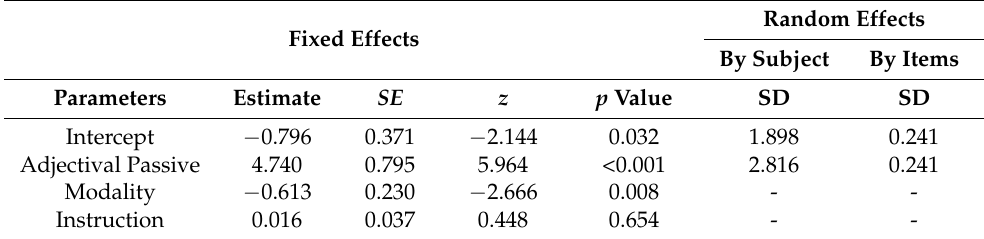
Table 10. Parameter estimates for HL learners ‘comprehension of passives by modality and